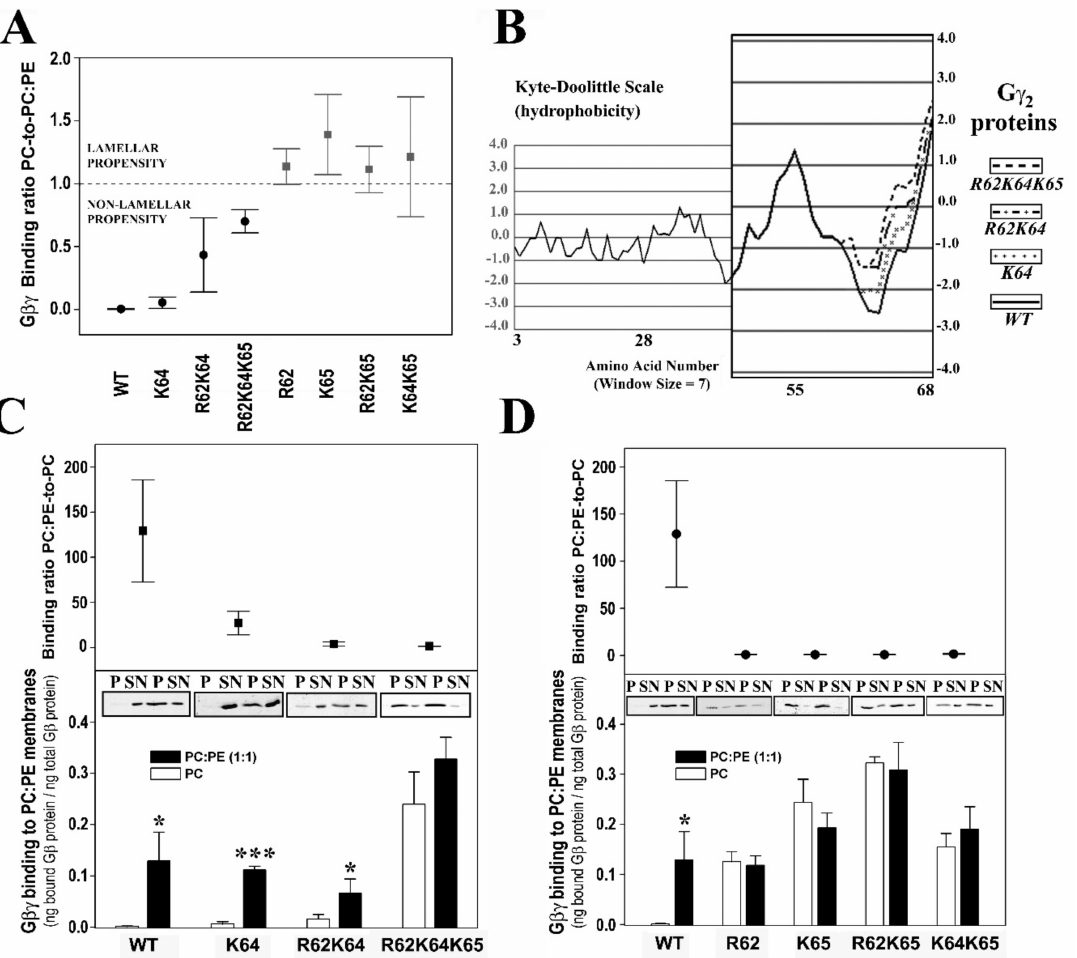
Figure 2. The influence of PE and G γ 2 structure on G βγ -membrane interactions. ( A ), Binding ratio PC-to-PC:PE corresponding to the different geranylgeranylated dimers are generated. The